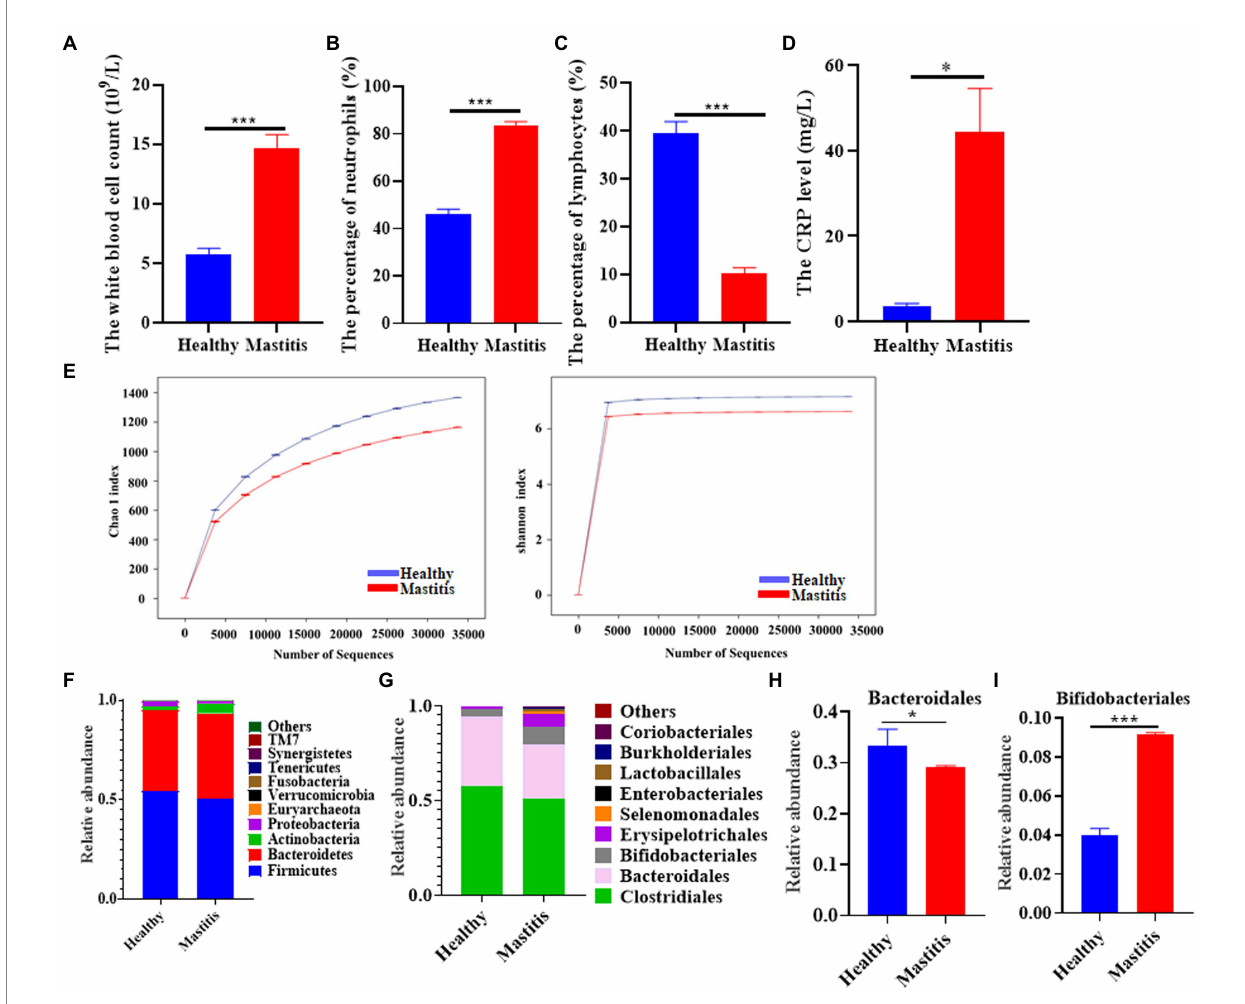
FIGURE 1 The pattern of immune response markers and intestinal flora in healthy females and patients with lactation mastitis. (A) The number of white corpuscles, (B) the percentage of neutrophils and (C) lymphocytes, and the level of (D) CRP were counted. (E) Alpha diversity, including Chao 1 and Shannon diversity index. (F) shows the gut microbiota composition in terms of relative abundance at the phylum level. (G) shows the gut microbiota composition in terms of relative abundance at the order level. (H,I) Relative abundances of bacteroidales and Bifidobacteriales between healthy and mastitis. The data represent the means ±SEMs ( n = 8–9 person per group). * p < 0.05, *** p < 0.001 by t